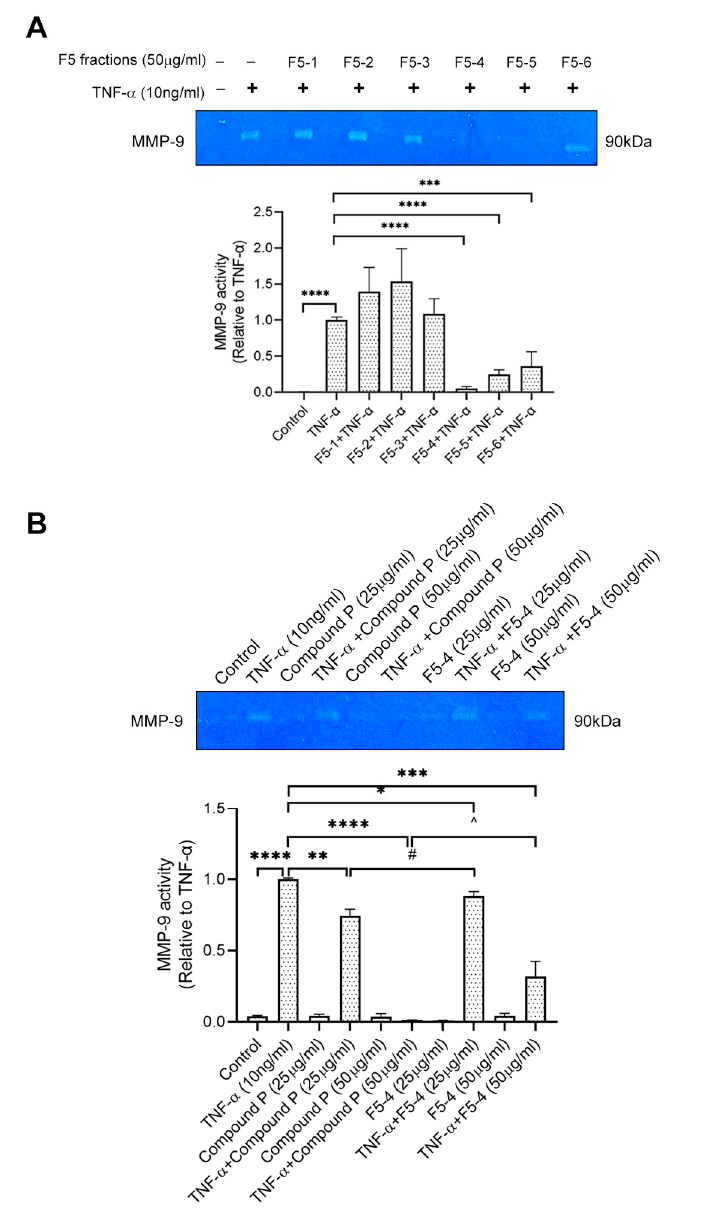
Figure 3. Effect of F5 subfractions (F5-1 to F5-6) and Compound P on TNF- α -induced MMP-9 activ- ity using gelatin zymography. ( A ) H9c2 cells were seeded at 5 × 10 4 cells/mL. After being pretreated with the six subfractions of F5 (50 μ g/mL) separately for 24 h, the cells were stimulated by recombi- nant rat TNF- α (10 ng/mL) for another 72 h. ( B ) H9c2 cells were pretreated with compound P (25 μ g/mL, 50 μ g/mL) and F5-4 (25 μ g/mL, 50 μ g/mL) separately and then stimulated by recombinant